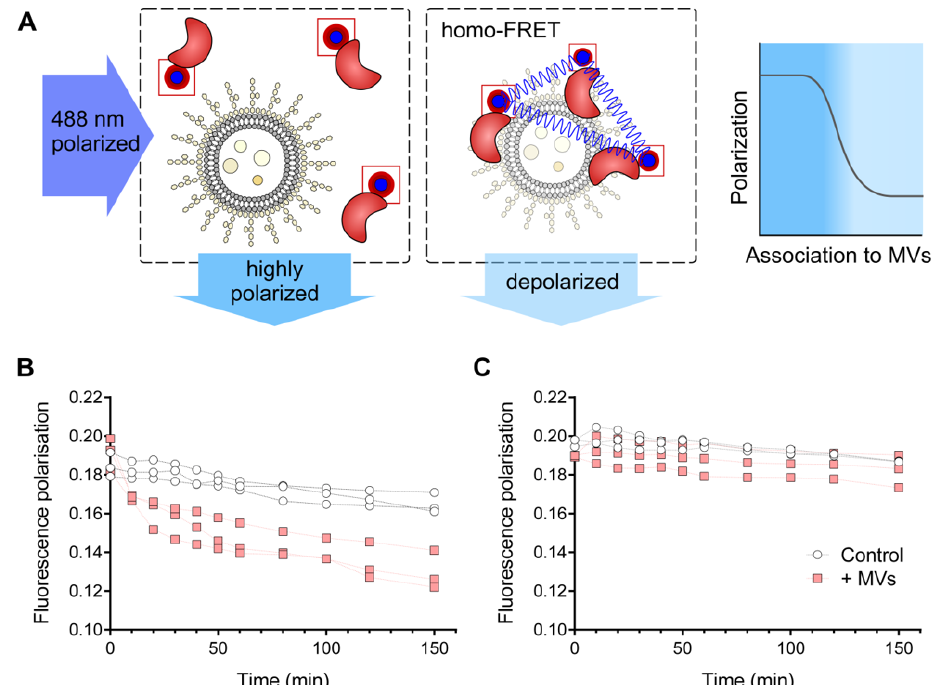
Figure 3. ( A ) Schematic illustration of the homo-FRET interaction assay with fluorescently labeled enzymes. The horizontal dark-blue arrow indicates the polarized excitation light. Interaction with or adsorption of the fluorescently labeled enzyme (red) to the vesicle surface brings the fluorophore molecules (blue) into spatial proximity, leading to FRET and hence to a decrease in polarization, indicated by the vertical light blue arrow (homo-FRET box, center). Without interaction with MVs, the emitted light (vertical blue arrow) remains highly polarized (left box). ( B , C ) Fluorescence polarization of ( B ) labeled HQD S . b . -Dy488 and of ( C ) AqdC-Dy488 in the presence or absence (control) of 0.2 mg/mL of P. aeruginosa MVs (protein-based concentration), measured at 488 nm excitation and 519 nm emission wavelength over 150 min at the indicated time intervals. Three independent experiments were performed. The lines connecting the data points collected from each replicate are for illustrative purposes